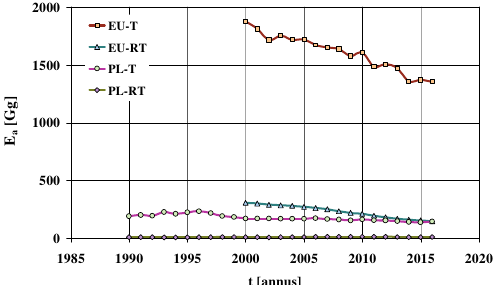
Fig. 6. Annual emission of particulate matter PM2.5: total in the Euro- pean Union – EU-T, from motor vehicles in the European Union – – EU-RT, total in Poland – PL-T, from motor vehicles in Poland – Fig. 2. Annual emission of non-methane volatile organic compounds: – PL-RT in years total in the European Union – EU-T, from motor vehicles in the Europe- an Union – EU-RT, total in Poland – PL-T, from motor vehicles in Poland – PL-RT in years 1990–2016